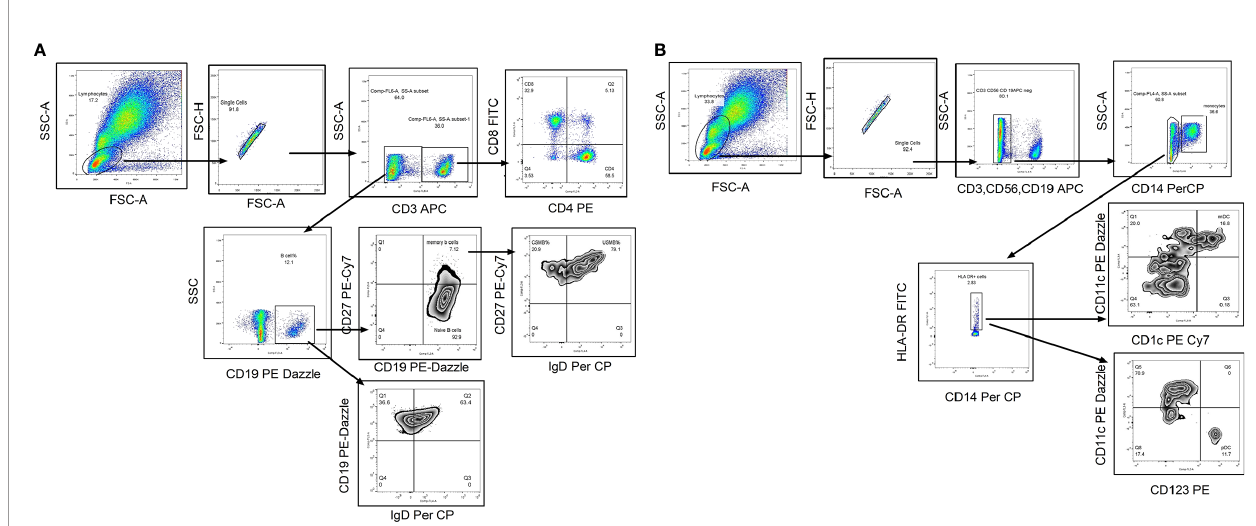
FIGURE 2 | Flow cytometry gating strategy to identify lymphocyte subsets. Representative fl owcytometry dot plots from the PBMCs of one of the study participants. (A) Gating strategy used to identify T cells and B cell subsets. The lymphocytes were live gated during acquisition using the side and forward scatter dot plot display. Lymphocyte population was further discriminated on the basis of CD3 expression. CD3 positive population was used to identify CD4 and CD8 T cells. Whereas CD3 negative population was used to identify B cells and its subsets such as memory B cells and class switched/unswitched B cells, class switched memory B cells (CSMB) and unswitched memory B cells (USMB). (B) Gating strategy used to identify antigen presenting cells (mDC, pDC and Monocytes).During acquisition, with the help of side and forward scatter, cells of lymphomonocyte gate were identi fi ed and the cells from this population were further distinguished on the basis of absence of lineage markers (CD3, CD19 and CD56). Lineage negative population was further discriminated as CD14+ and CD14- population to identify monocyte population. CD14 negative population was again distinguished on the basis of HLA-DR expression. Both positive (CD11c and CD1C) population from HLA-DR positive cells was identi fi ed as myeloid Dendritic Cells (mDC). Plasmacytoid dendritic cells (pDC) were identi fi ed as HLA-DR+CD11C − CD123 + cells. In infants with high NRBC (nucleated RBC) count, contour plot was used to identify lymphocyte gate for further